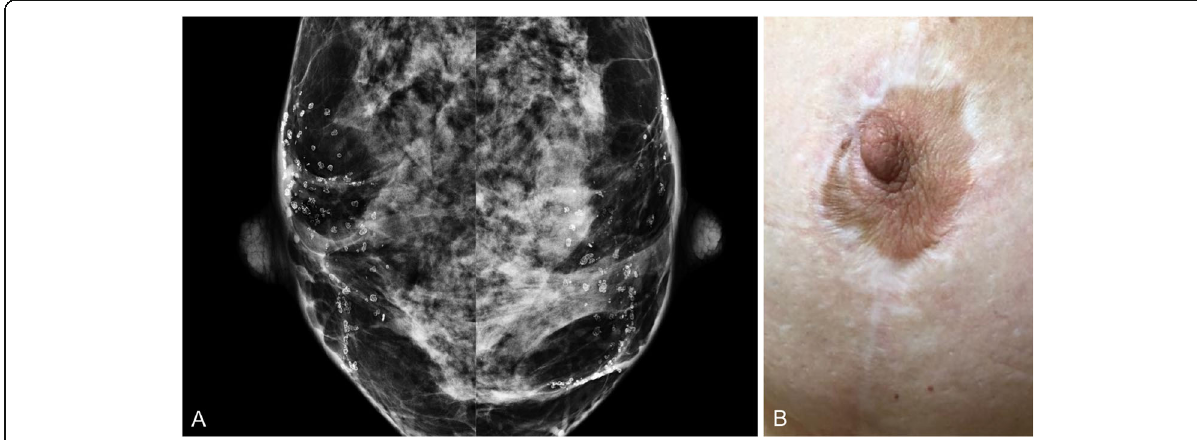
Fig. 10 Periareolar calcifications. A 47-year-old woman with a history of breast reduction surgery. a Synthesized craniocaudal 2D mammogram shows bilateral periareolar calcifications. b Photograph shows the periareolar